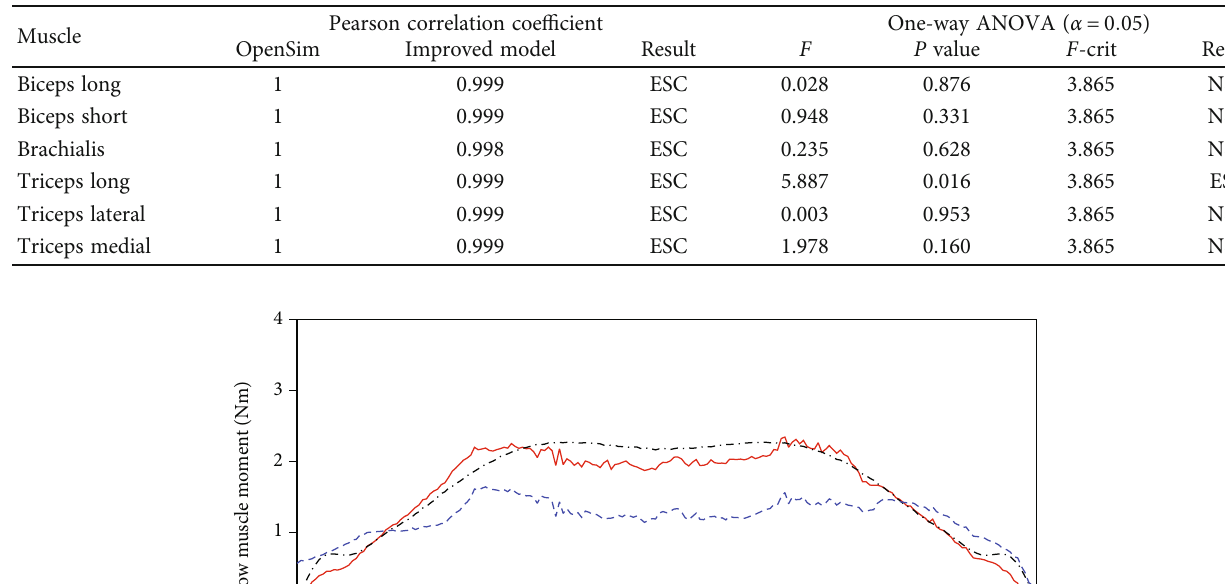
Table 5: Comparative analysis results of muscle length-time relationship.